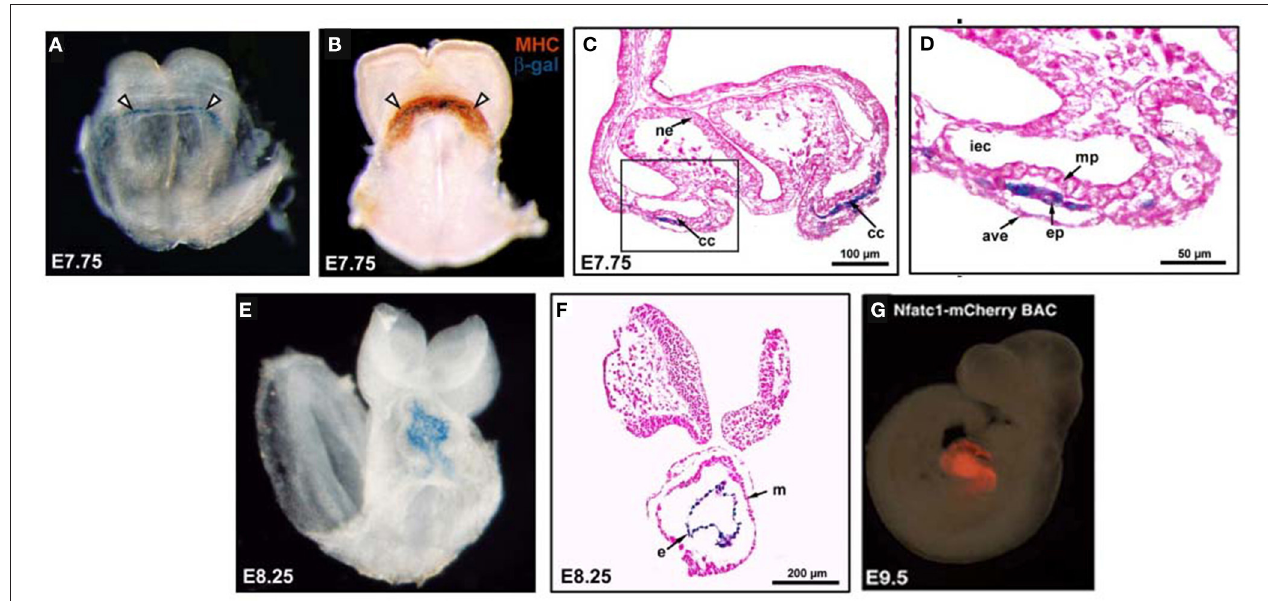
FIGURE 1 | The endocardium and myocardium are intimately associated during early differentiation . (A) An NFATc1-nuc-LacZ embryo, E7.75, stained with X-Gal. Nuclear expression of β -gal (blue) within the endocardium of the cardiac crescent (white arrowheads). (B) An E7.75 NFATc1-nuc-LacZ embryo stained with myosin heavy chain (MHC; reddish-brown) to identify the myocardium and co-stained with X-Gal to mark β -gal + (blue) endocardium within the cardiac crescent (white arrowheads). (C,D) E7.75 embryo coronal sections revealing blue β -gal + endocardial cells between the myocardial precursors and the anterior endoderm. mp, myocardial precursors; ep, endocardial precursor; ne, neuroectoderm; cc, cardiac crescent; ave, anterior visceral endoderm; iec, intraembryonic coelom. (E) X-Gal stained E8.25 NFATC1-nuc-LacZ transgenic embryo with blue β -gal expression confined to the endocardial layer of the linear heart tube. (F) Coronal sections of E8.25 NFATc1-nuc-LacZ embryo revealing blue β -gal expression specifically and exclusively in the endocardium. (G) Whole-mount immunofluorescence of an NFATc1-mCherry (BAC) E9.5 embryo confirms endocardium-specific mCherry expression [adapted from Misfeldt et al. (40) and Saint-Jean et al. (45)].